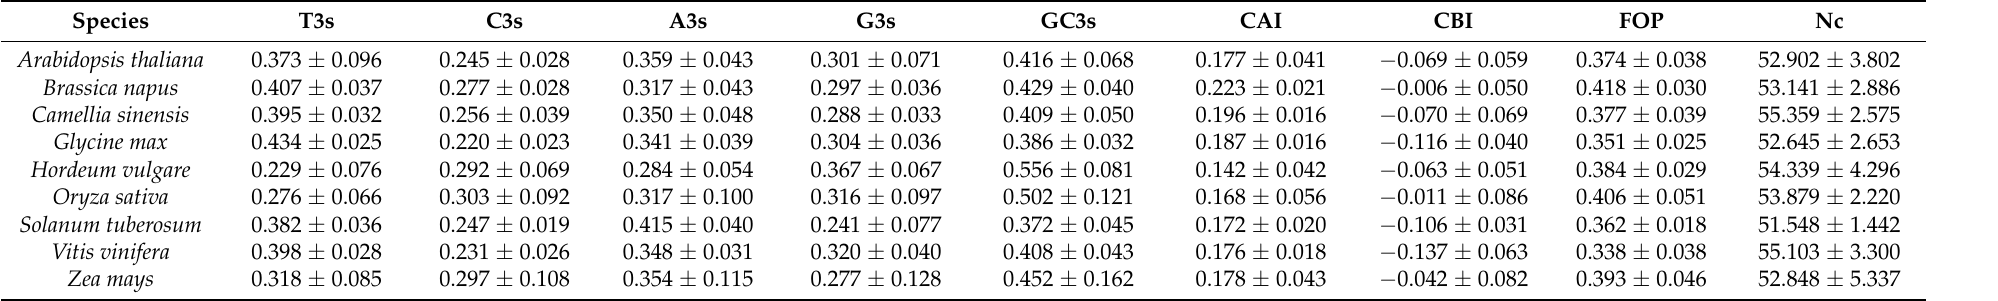
Table 2. Analysis of the codon usage index in nine